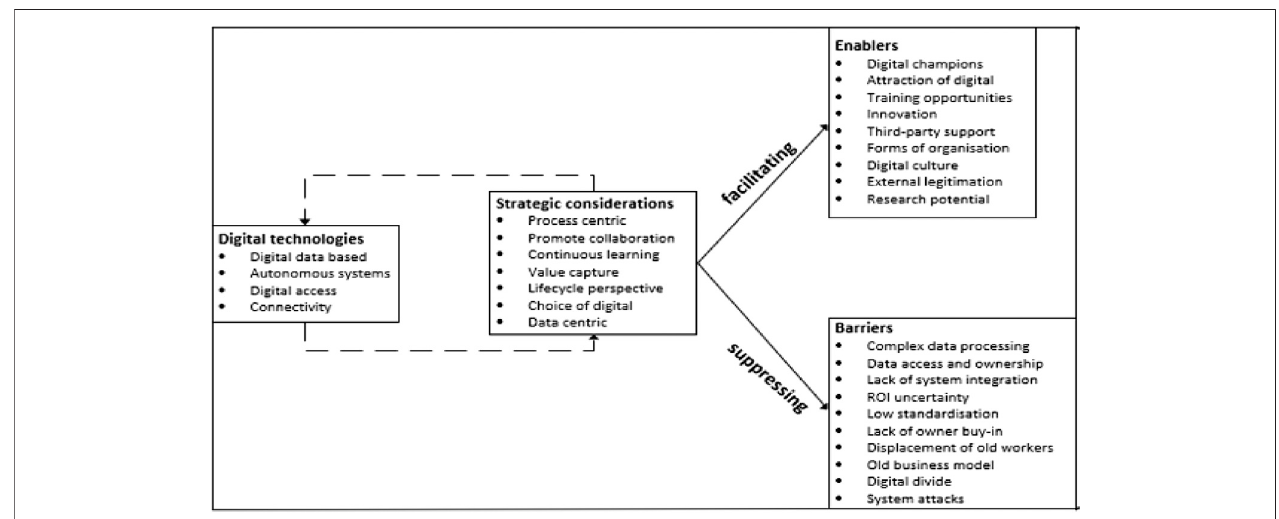
FIGURE 5 | Concepts of DT in